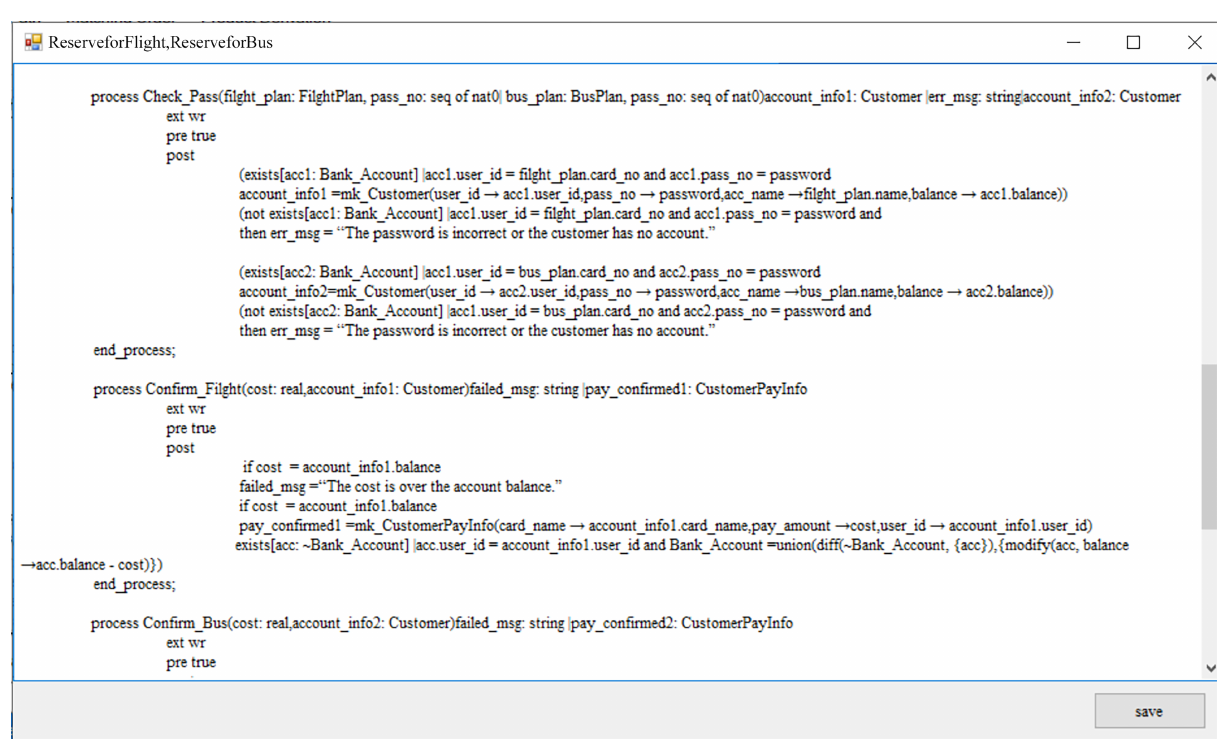
Figure 13. Formal specification of integrated feature